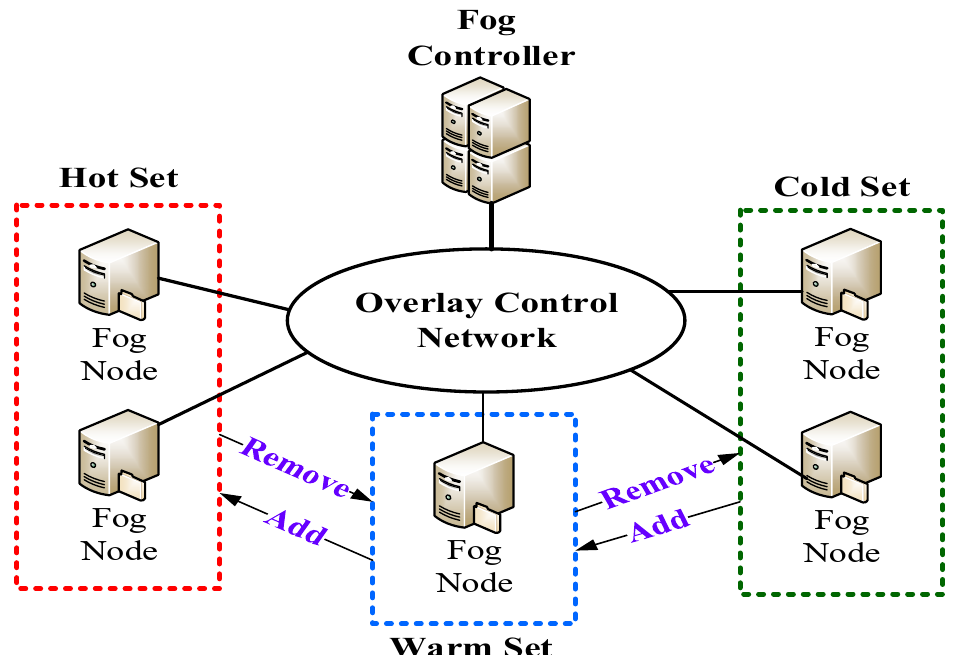
Figure 3. Architecture of intelligent energy perception.